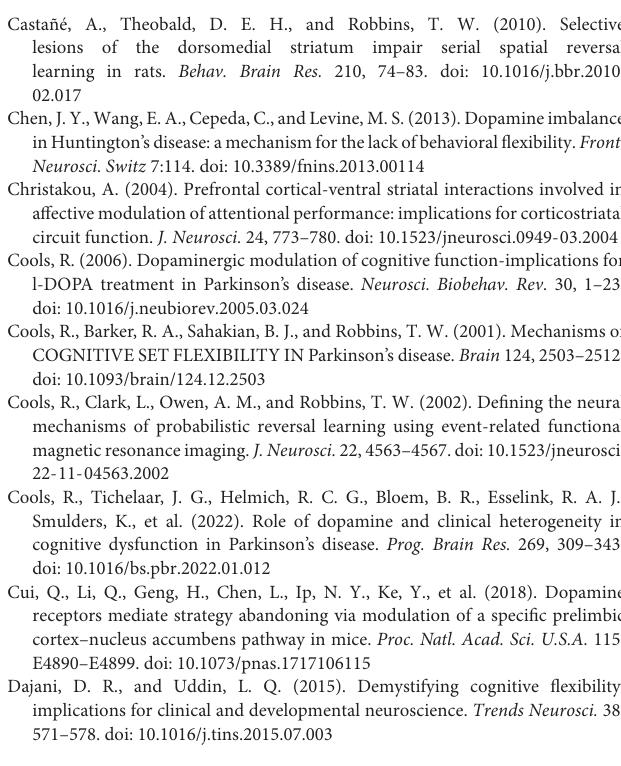
Supplementary Figure 1 | Mice demonstrate successful formation of attentional sets. D1-MSN-Blocked ( n = 8), D2-MSN-Blocked ( n = 9), and WTs ( n = 8, per group) took significantly more trials to reach the criterion in the extradimensional shift (EDS) stage than the intradimensional shift (IDS) stage, indicating all animals were able to successfully form an attentional set to the internal stimulus dimension that resulted in poorer performance when the set was shifted. Bars represent mean ± SEM; Bonferroni post-hoc tests (* p < 0.05, ** p < 0.01). Supplementary Figure 2 | Mean latencies to make correct responses in the attentional set-shifting task (ASST) were unaffected by neurotransmission release inhibition from NAc Core MSNs. NAc Core D1-MSN-Blocked ( n = 8) (A) and D2-MSN-Blocked ( n = 9) (B) mice did not significantly differ from wildtype (WT) controls ( n = 8) in their mean latency to make a correct response during discrimination [simple discrimination (SD) and compound discrimination (CD)], reversal [compound discrimination reversal (CDR), intradimensional set-shift reversal (IDR), and extradimensional set-shift reversal (EDR)], and set-shifting (IDS and EDS) stages of the ASST. Bars represent mean ± SEM. Supplementary Figure 3 | Omission trials in the attentional set-shifting task (ASST) following NAc Core D1- and D2-MSN neurotransmitter release inhibition. The total amount of omission trials in discrimination (SD and CD), reversal (CDR, IDR, and EDR), and set-shifting (IDS and EDS) stages of the ASST did not significantly differ between WT ( n = 8 per group) mice and NAc Core D1-MSN-Blocked ( n = 8) (A) or D2-MSN-Blocked ( n = 9) (B) mice. Bars represent mean ± SEM. Supplementary Figure 4 | Mean incorrect latency was negatively correlated with trials to criterion in reversal stages. In both WT ( n = 8) (A,C,E) and NAc D2-MSN-Blocked ( n = 9) (B,D,F) mice, the mean incorrect latency was negatively correlated with trials to criterion in all reversal stages (CDR, IDR, and EDR). Additionally, the mean correct latency was negatively correlated with trials to criterion in IDR and EDR stages in WT mice (C,E) and CDR and EDR stages in NAc Core D2-MSN-Blocked mice (B,F) . Lines of best fit have been fitted to each correlation plot using simple linear regressions. Additionally, Pearson’s r values and the statistical significance of each correlation are